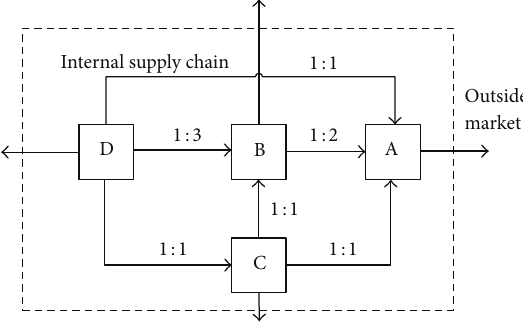
Figure 2: A manufacturing supply chain